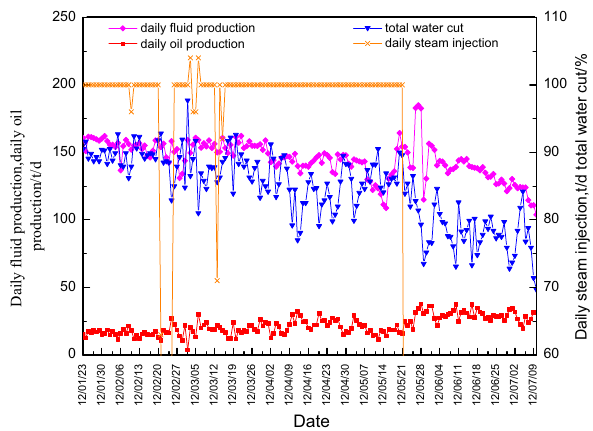
Figure 11: Curves of steam drive production performance of Qi40 - 19 - k028 well